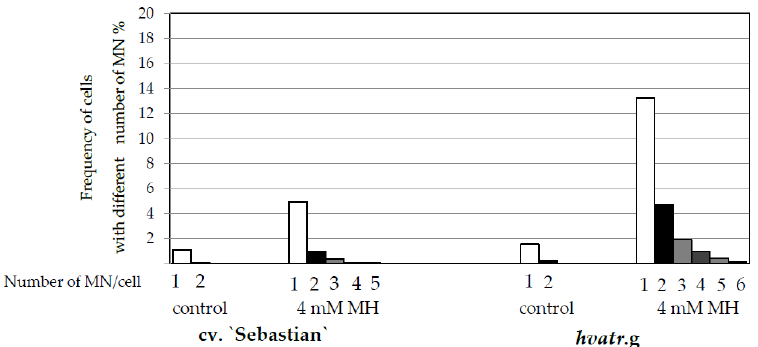
Figure 5. Frequencies of cells with different number of micronuclei (MN) in root cells of barley seedlings of the hvatr.g mutant and cv. “Sebastian”, control and MH-treated. The number of micronuclei is shown below the X axis.